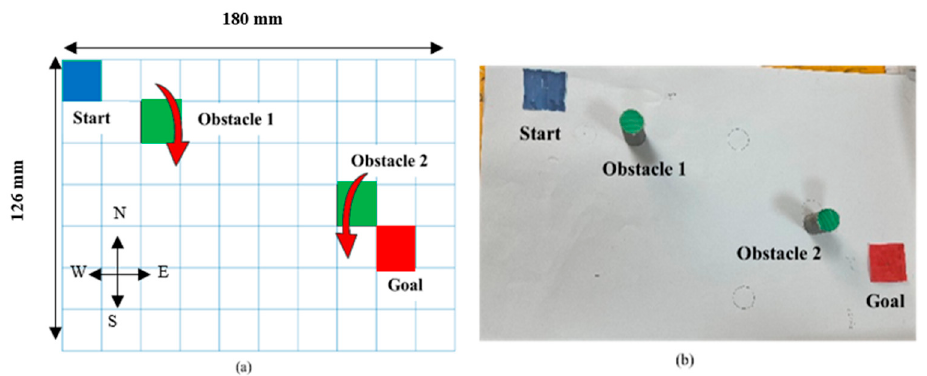
Figure 5. ( a ) Simulated Grid World Environment ( b ) Real-time Grid World Environment in Robot Workspace.